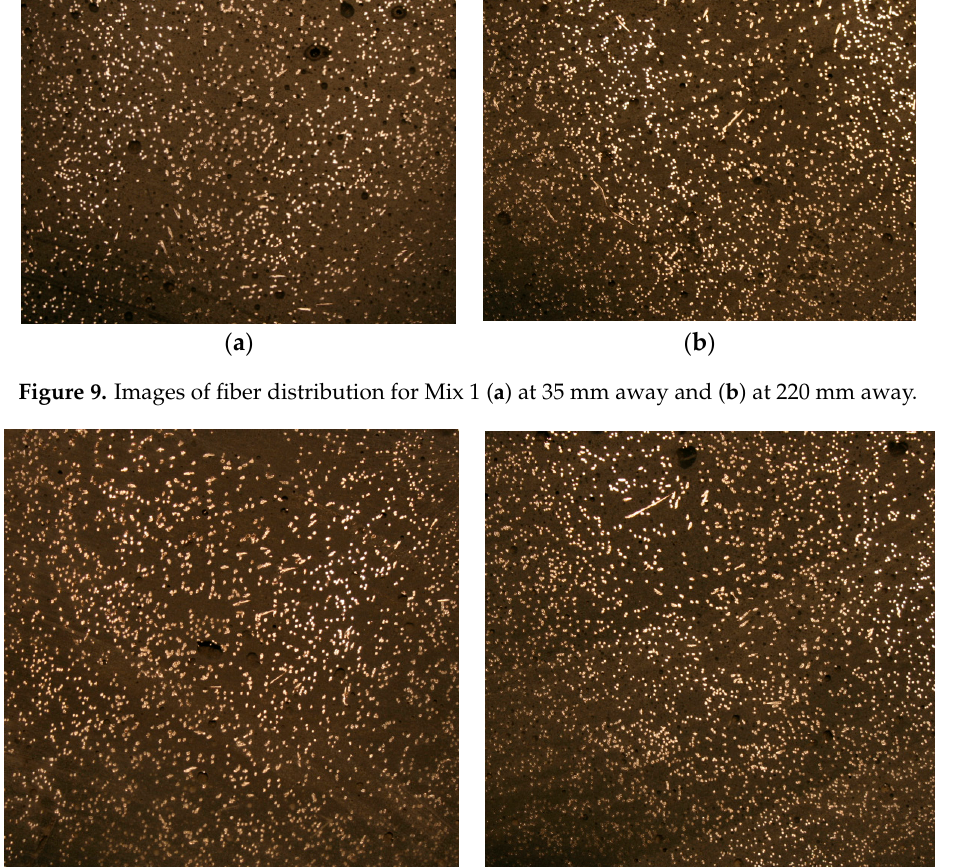
Figure 11. Fiber orientation coefficients and fiber dispersion coefficients of UHPFRC.